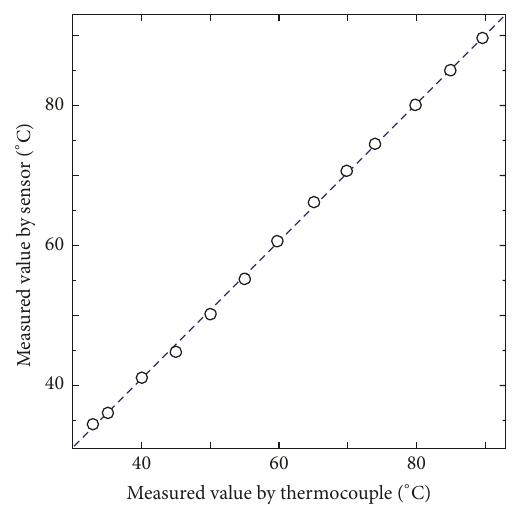
Figure 6: Comparison of a cooling flow process with a conventional